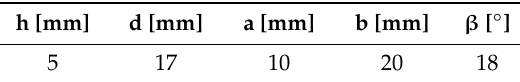
Figure 5. Airfoil equipped with vortex generators (VGs): ( a ) row of vane-type VGs; ( b ) detailed view of VG pair with geometric dimensions. Table 1. Geometric measures of VG.